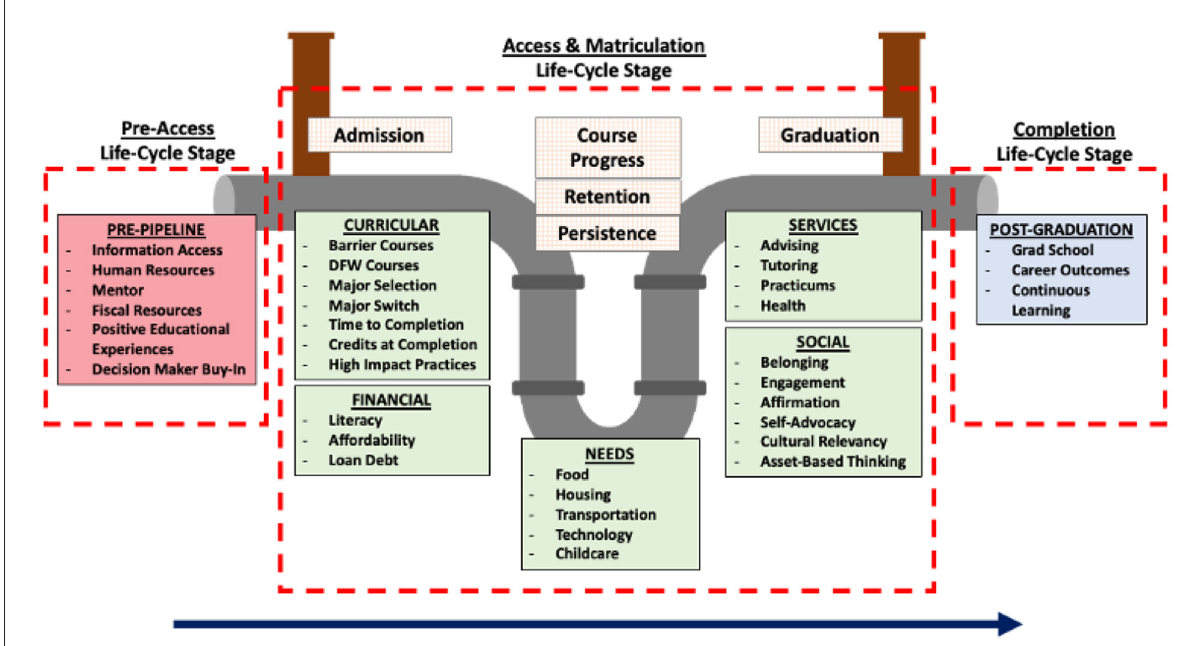
FIGURE1 The Life-Cycle Educational Assessment Pipeline (LEAP) is a life-cycle based assessment framework for institutions of higher education to leverage institutional data to enhance and drive toward school and student success. LEAP is comprised of three life-cycle stages: Pre-Access, Access and Matriculation, and Completion. Residing in each life-cycle stage are measurement cluster(s) that track specific school and student success measures. The red box at Pre-Access is the pre-pipeline cluster which captures the factors inhibiting access to higher education. Following access, the green boxes at Access and Matriculation capture the factors affecting student progress, many of which negatively affect retention and persistence. The orange checkered boxes in Access and Matriculation represent the measures typically reported by IHEs. The blue box at Completion is the cluster capturing the post-graduation trackable